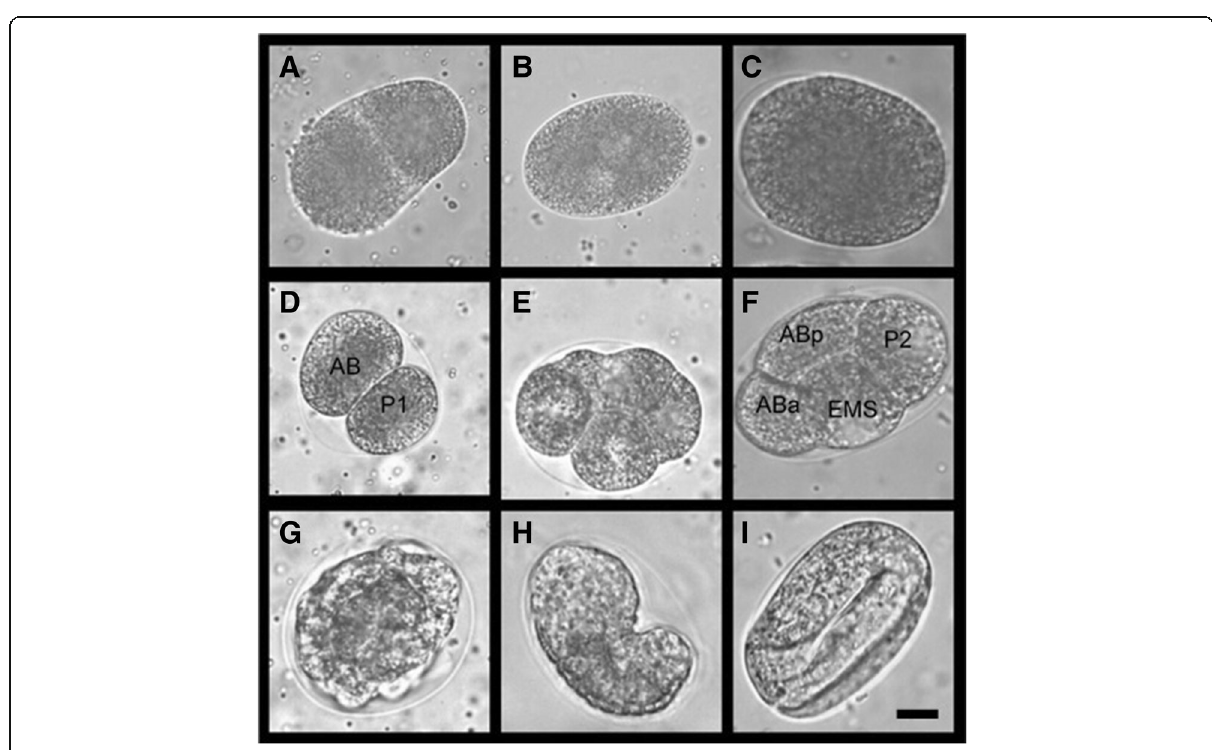
Fig. 3 H. indica SL0708 egg developmental stages. a Stage 1. b Stage 2. c Stage 3. d Stage 4. e Stage 5. f Stage 6. g Stage 7. h Stage 8. i Stage 9. (Scale bar = 10 μ